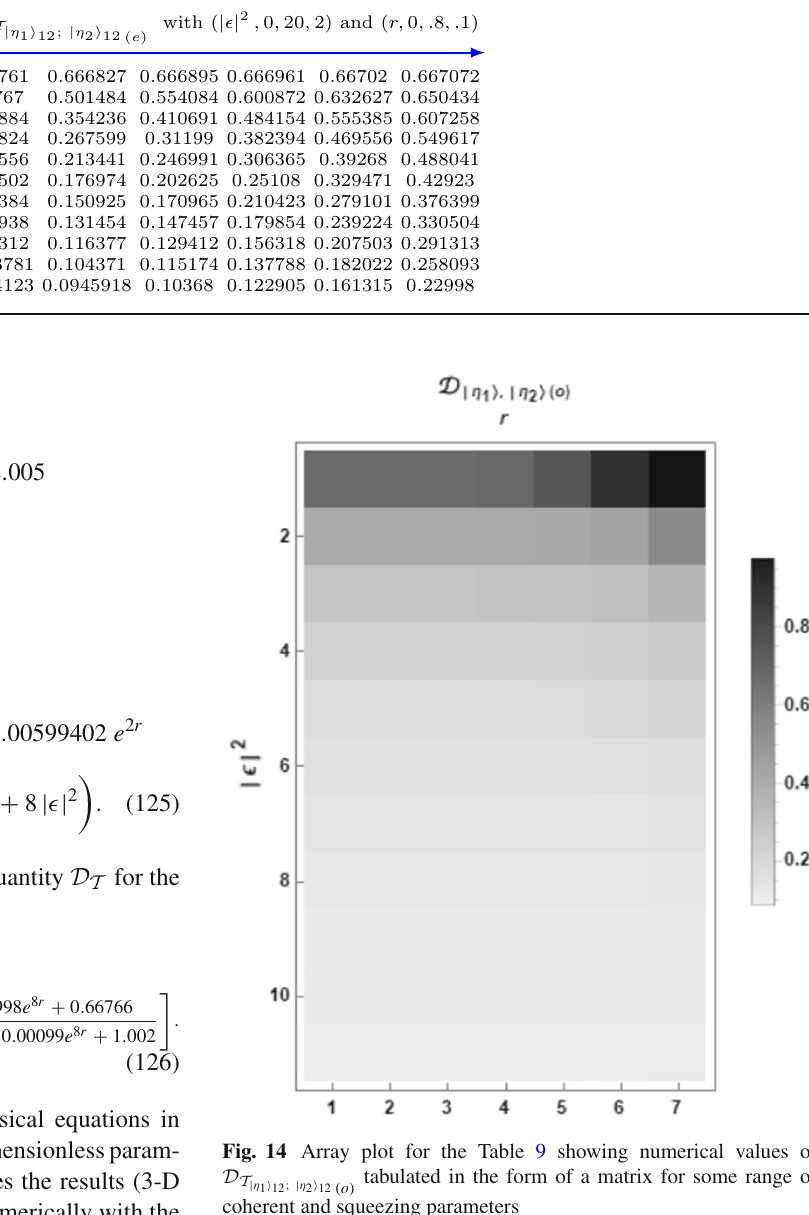
D T | η 1 (cid:3) 12 ; | η 2 (cid:3) 12 ( o )